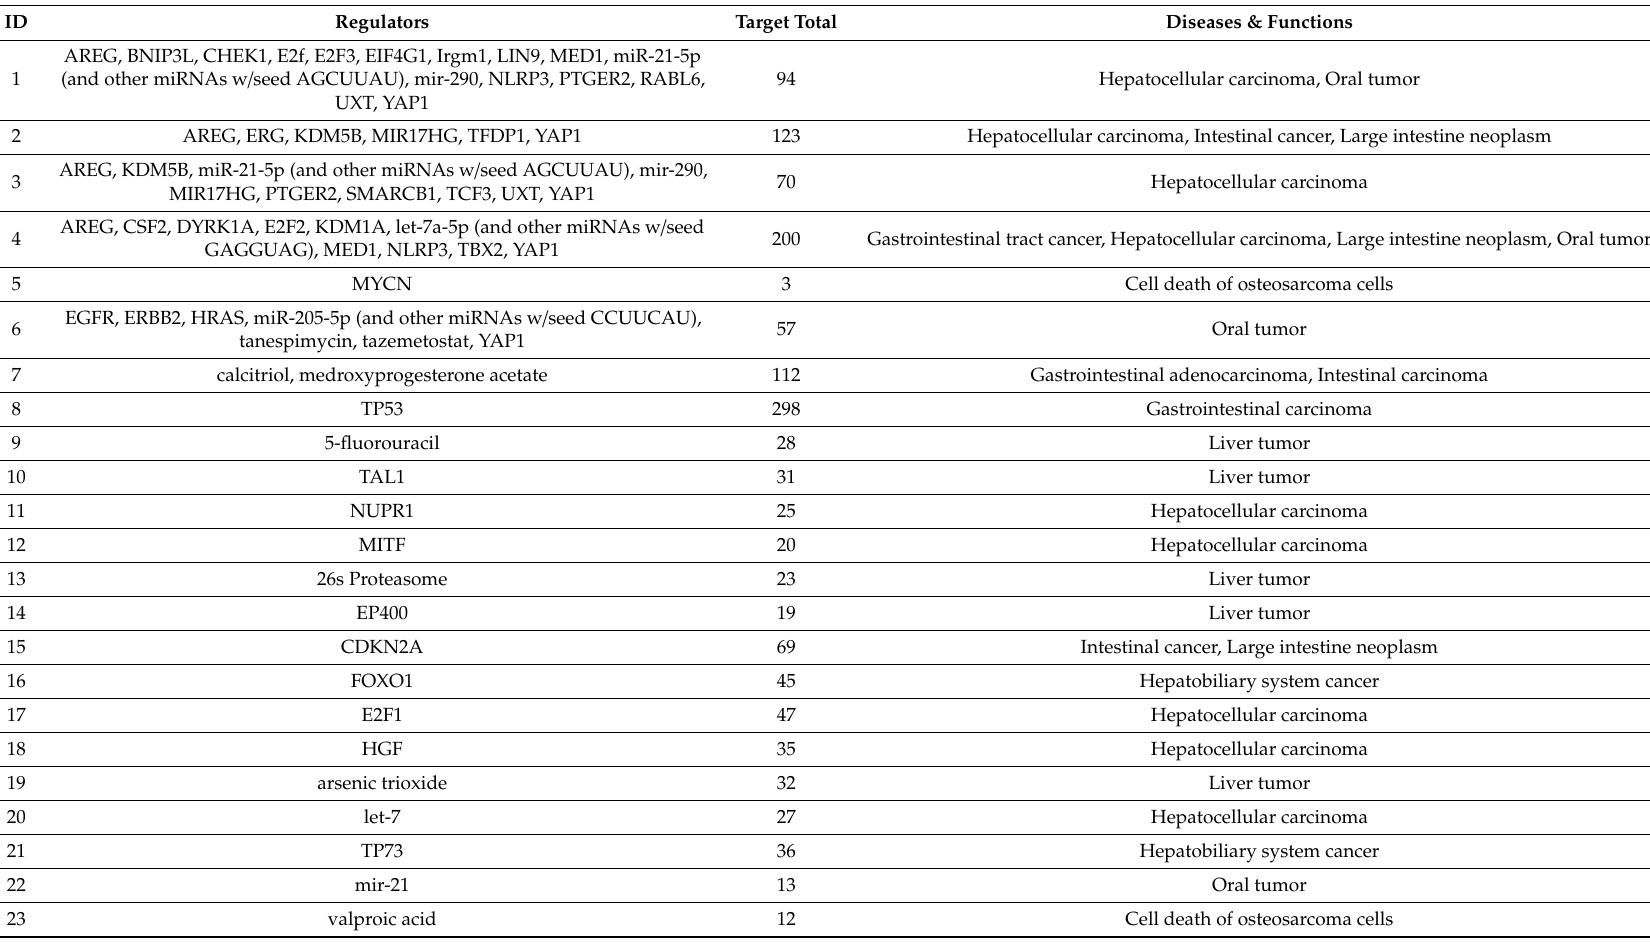
Table 3. Regulator e ff ect networks related to cancer in intestinal-type gastric cancer (GC). Regulator e ff ect networks related to cancer have been generated. Type of regulators include biological drug, canonical pathway, and chemical